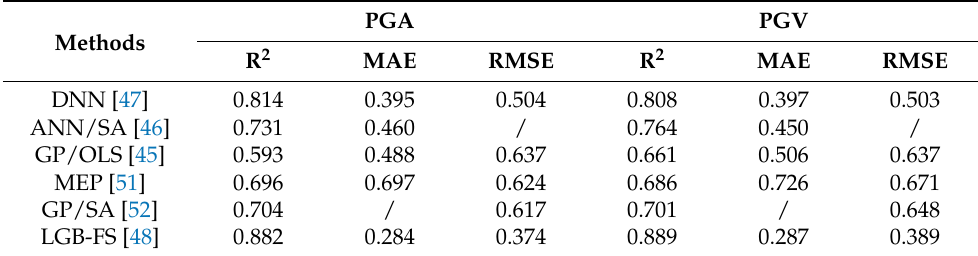
Table 3. Performance comparison of the LGB-FS for ground motion prediction with other methods.